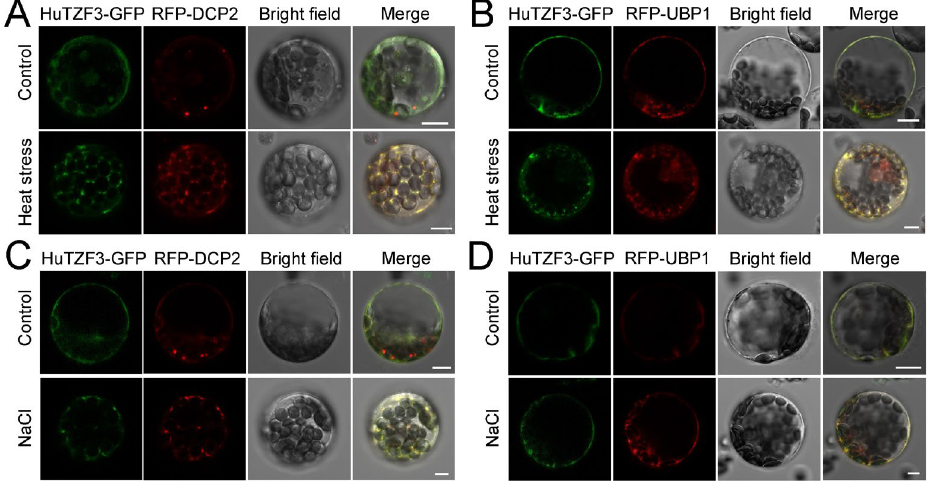
Figure 6. HuTZF3 co - localized with RNA processing bodies (PBs) and stress granules (SGs) marker proteins under heat and salt stress . ( A , B ) The HuTZF3-GFP was co - transformed with the PB marker RFP-DCP2 ( A ) and the SG marker RFP-UBP1 ( B ) into Arabidopsis protoplasts, and then cultured under control conditions (22 °C), or heat stress , at 39 °C for 30 min , before observation. ( C , D ) The HuTZF3-GFP was co - transformed with the PB marker RFP-DCP2 ( C ) and the SG marker RFP-UBP1 ( D ) into Arabidopsis protoplasts, and then cultured under control conditions, or salt stress with 150 mM NaCl for 1 h , before observation. Scale bar = 10 µm.